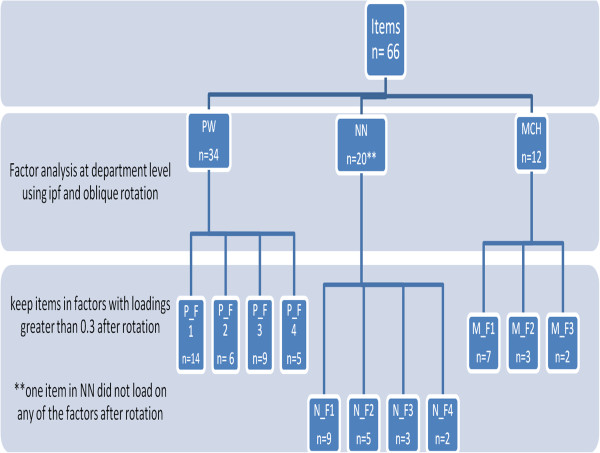
Number of items per factor/domain extracted from EFA. The figure illustrates factor extraction from the exploratory factor analysis carried out at the department level. The number of items in each of the factors in each of the departments is shown on the lower level of the chart.